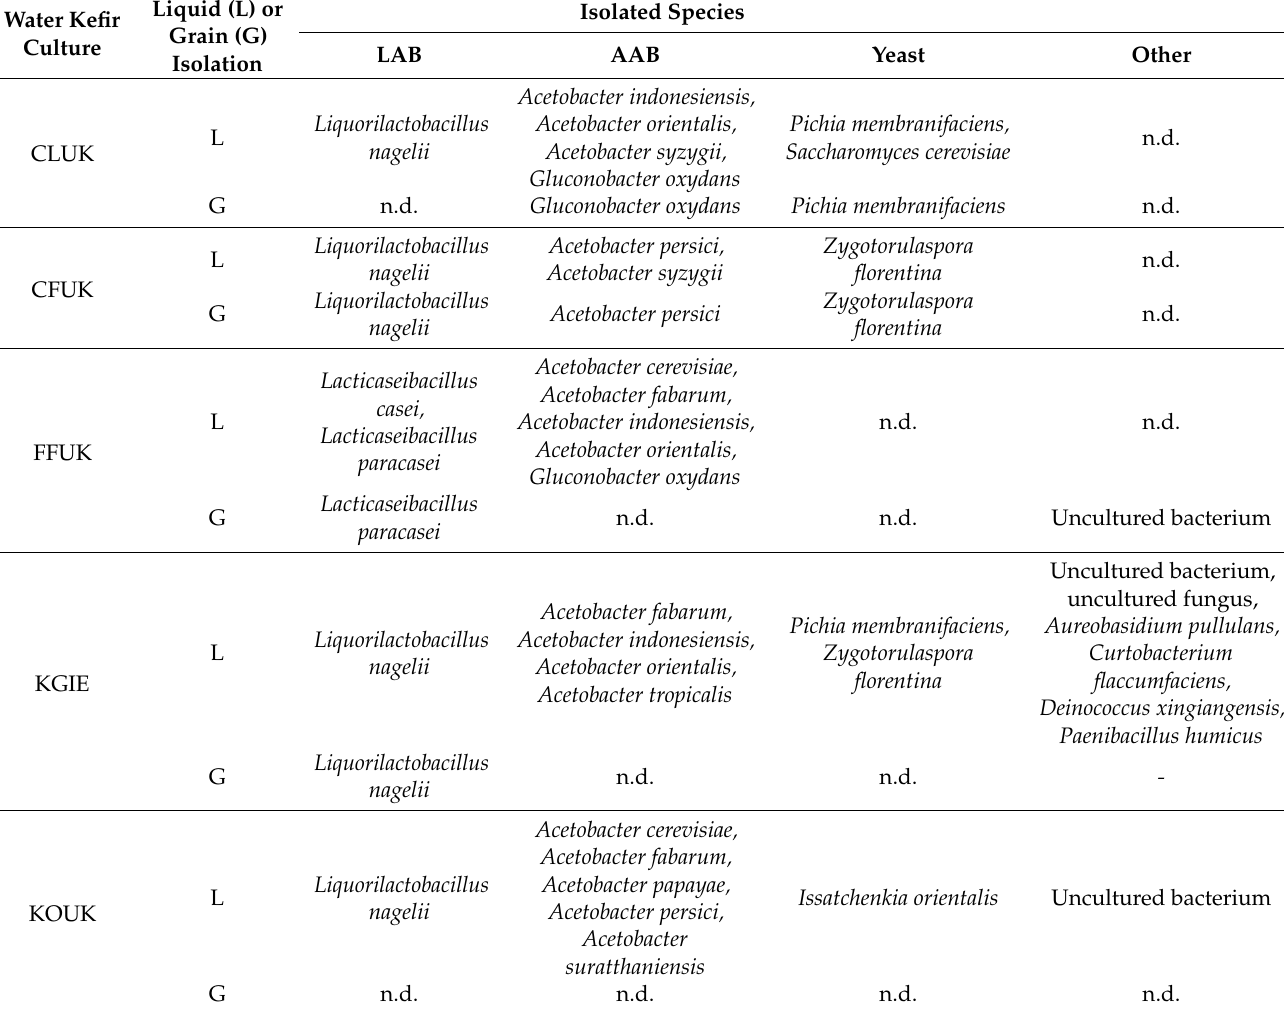
Table 4. Microorganisms isolated from water kefir cultures used in the nitrogen limitation